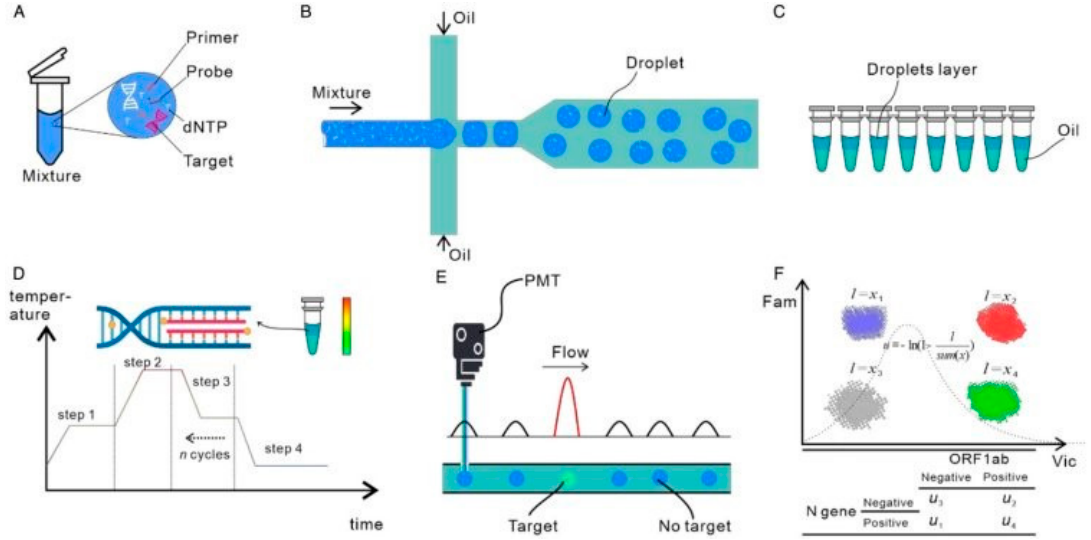
Figure 2. Schematic depicting workflow of a ddPCR system: ( A ) preparation for amplification, ( B ) generation of water-in-oil droplets using a microfluidic flow system, ( C ) collection of the droplets in PCR tubes, ( D ) PCR amplification, ( E ) analysis of fluorescence in the droplets after amplification, and ( F ) fitting to Poisson distribution to determine the absolute copy numbers of the target molecules (Reprinted from Ref. [28]).